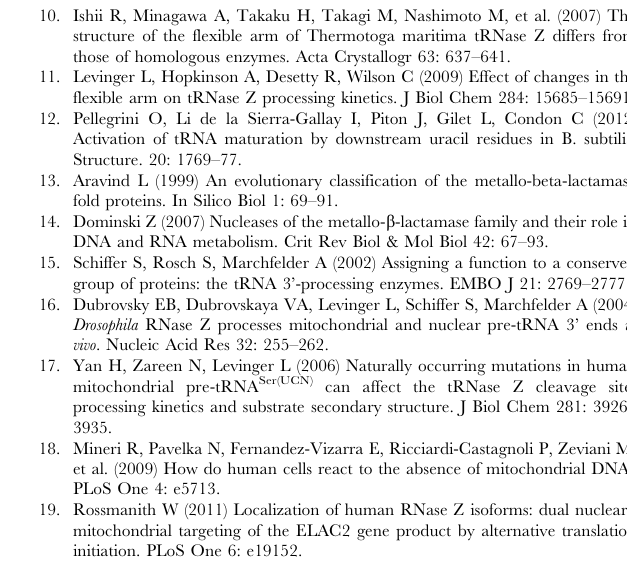
Figure SF1. tRNA in a complex with tRNase Z S . Figure SF2. Full length tRNase Z L alignments. Table ST1. Wild Type D. in Figure 3B. Table ST2. Predicted members of D. melanogaster tRNase Z C dom 2 family. Figure SF3. D. melanogaster tRNase Z – Trypsin Full Length Coverage. Table ST3. Compilation of D. melanogaster tRNase Z peptide MALDI-Ion trap. Figure SF4. D.